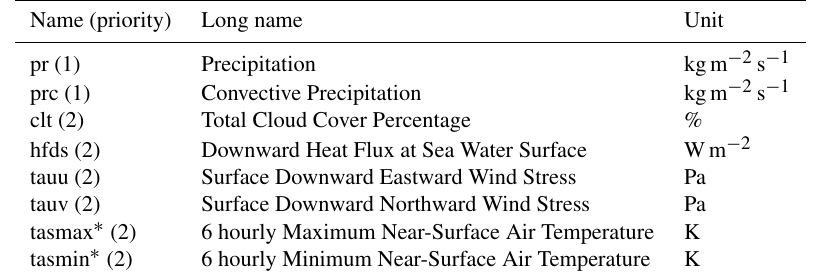
Table 2. Variables in the 6hr data table. Surface (XYT) output averaged over 6h intervals. See Sect. 5 for meaning of priority levels.